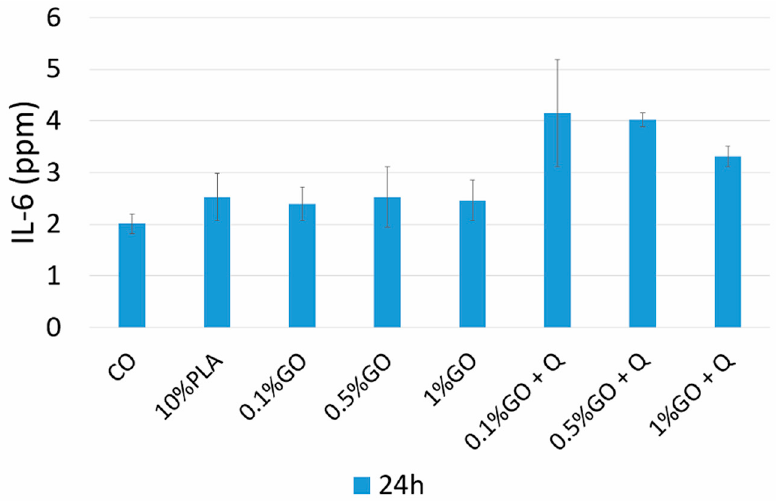
Figure 11. IL-6 release.